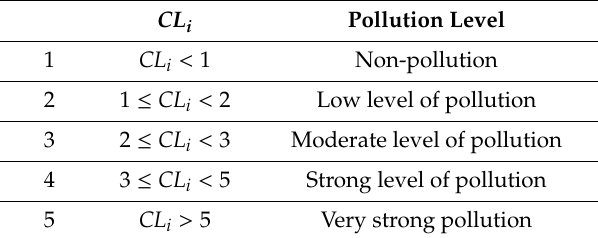
Table 6. Category of contamination index.